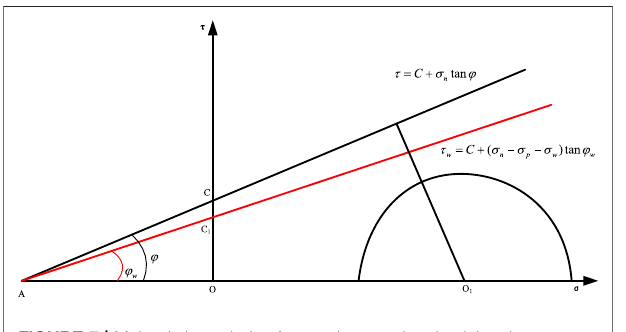
FIGURE 7 | Mohr circle analysis of stress in water bearing jointed limestone.